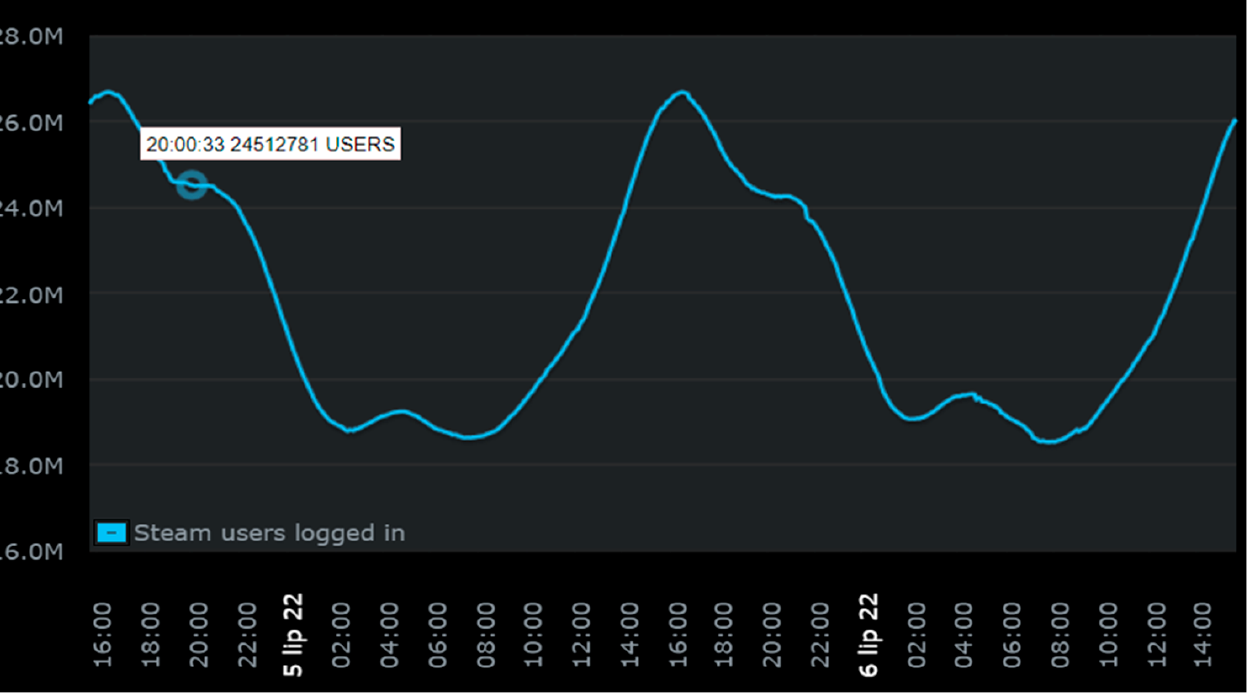
Figure 1. The number of Steam users—data on 5–6 July 2022 [accessed: 6 July 2022, 3:44 p.m. (GMT+2:00) Warsaw], source of Figure: [35].